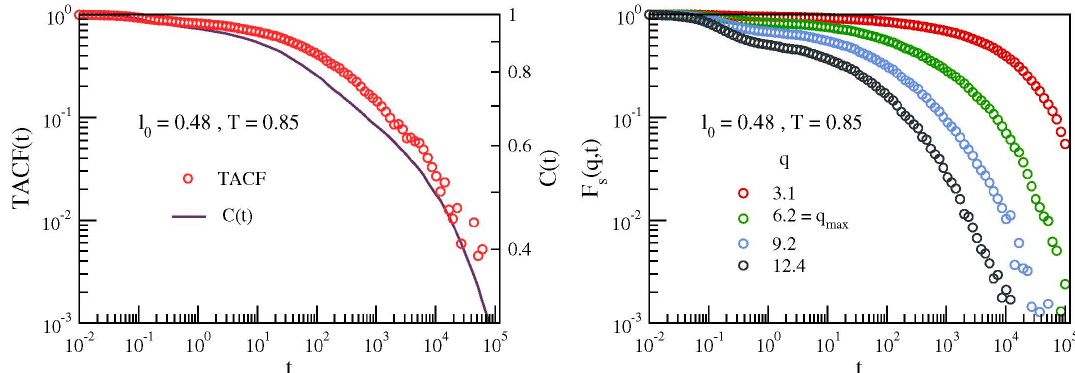
Figure 9. Left: comparison between the torsional autocorrelation function (TACF) and the bond-orientation correlation function, C( t ) for the system with stronger secondary relaxation ( l 0 = 0.48) at the lowest investigated temperature ( T = 0.85). Notice the step observed in both functions at t ∼ 4 · 10 3 , signalling the secondary relaxation, see Figure 2, left. The step is much more apparent in C(t), occurring when the latter is dropped of ∼ 40% only. The same feature is observed in TACF when more than 90% of the decay has been completed. Right: corresponding intermediate scattering function (ISF) for di ff erent wavevectors in a range including q = q max , corresponding to the maximum of the static structure factor. No apparent two-step decay is